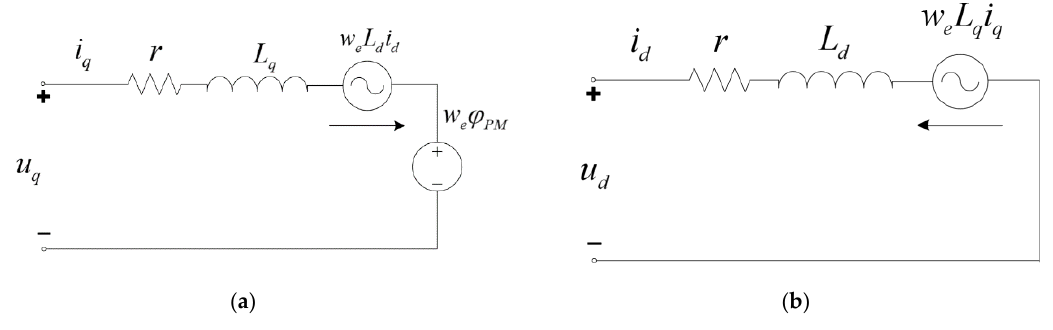
Figure 3. Equivalent circuit. ( a ) in q axis; ( b ) in d axis.